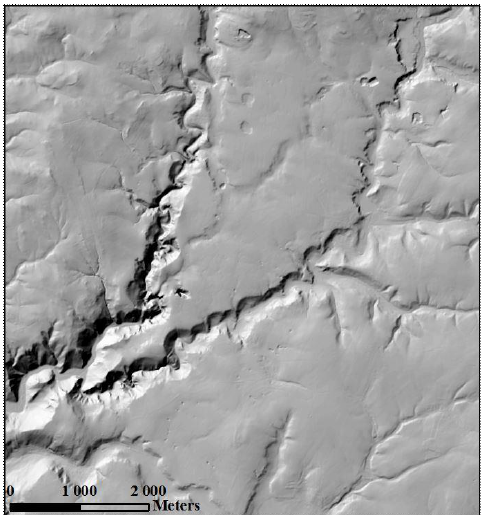
Figure 2. Shading of the DMR 4G for the study area in